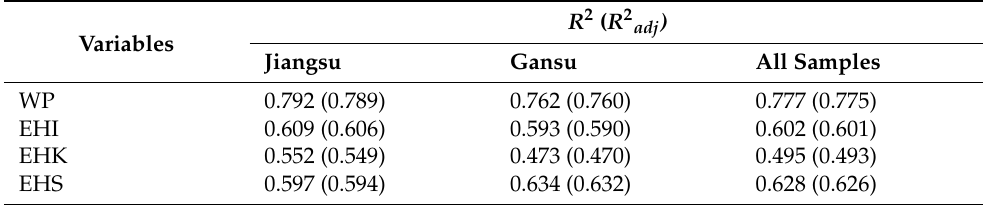
Table 6. Endogenous latent variables R 2 and R 2 adj .